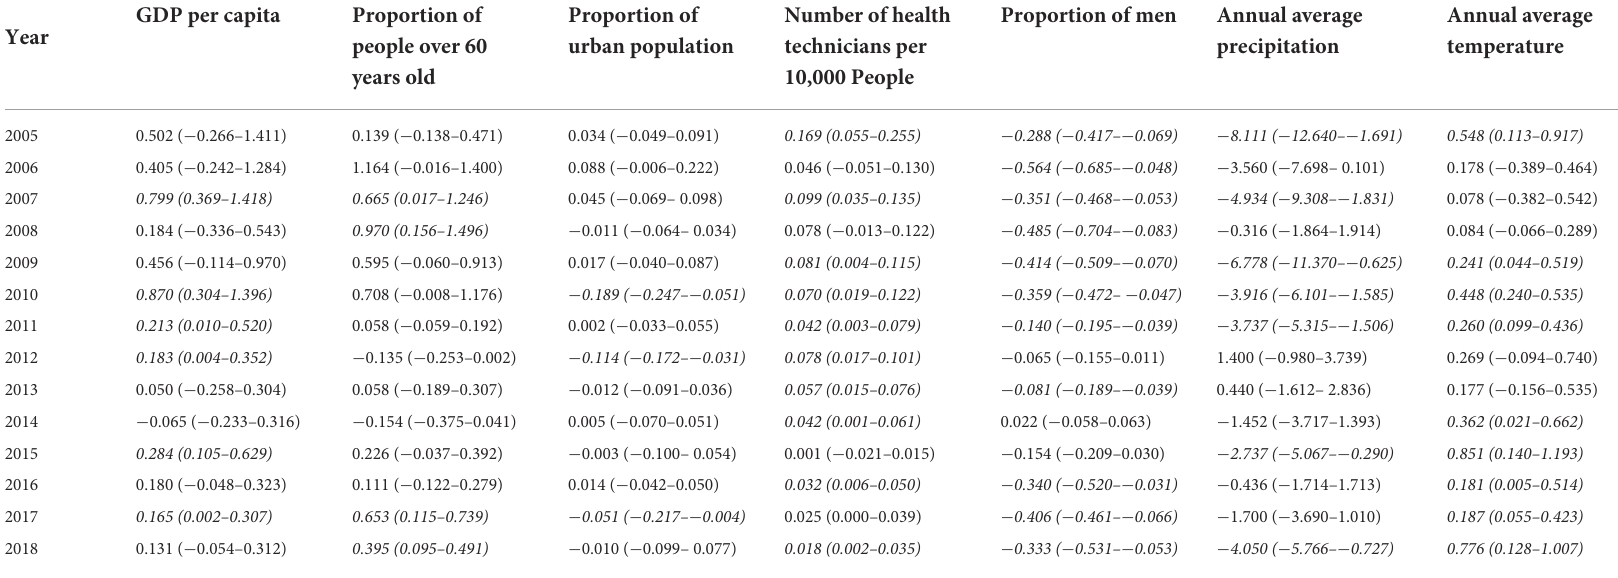
TABLE 3 Partial regression coefficient estimates and 95% confidence intervals for related social variables of syphilis in Bayesian spatial CAR model in Zhejiang Province,